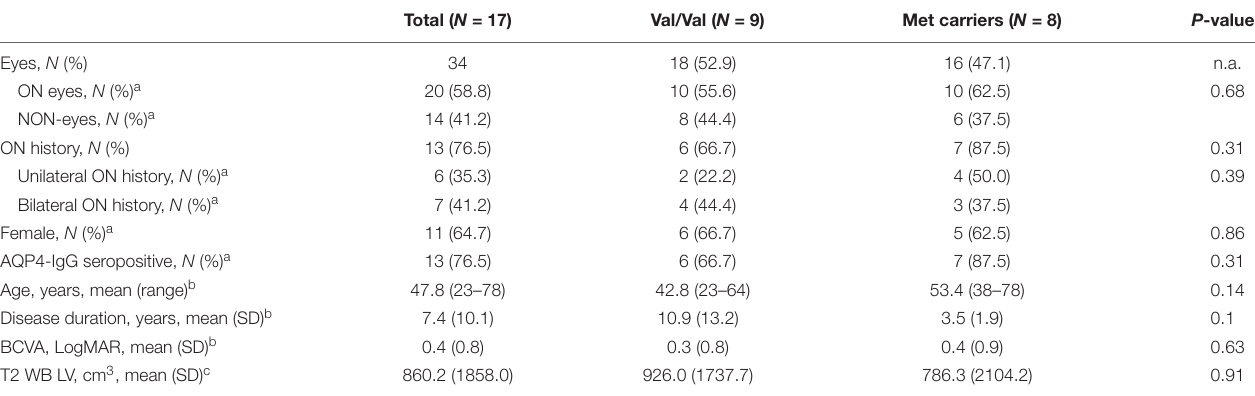
TABLE 1 | Demographic and clinical characteristics of